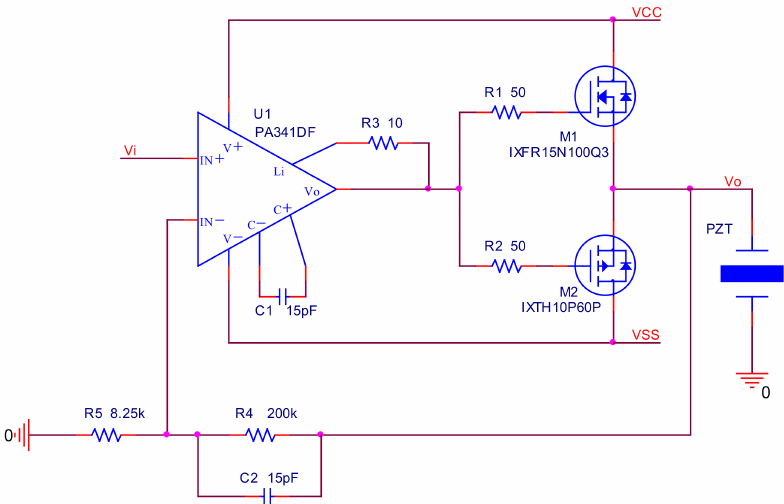
Figure 8. The schematic of the power amplifier using high-voltage amplifiers.